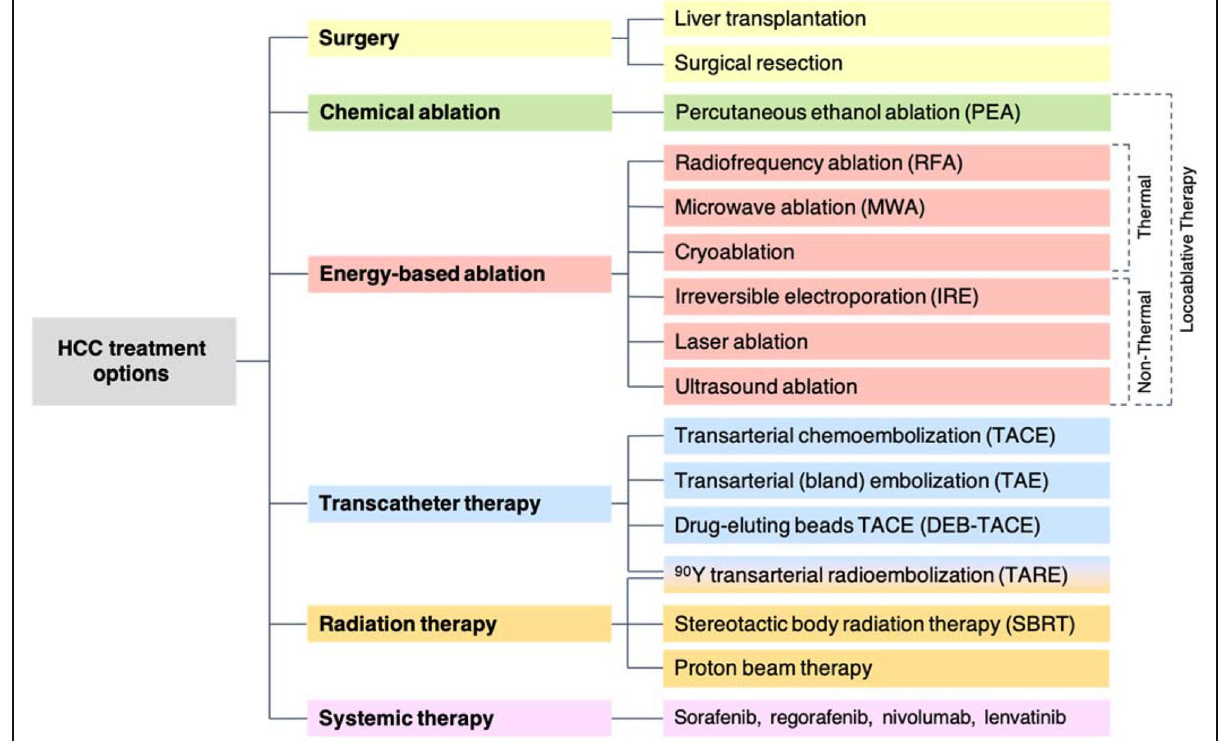
Fig. 3 Hepatocellular carcinoma (HCC) treatment options divided by modality. Locoablative therapies (PEA, RFA, MWA), transcatheter therapies (TAE, TACE, DEB-TACE, TARE) and radiation therapies (SBRT) are the most commonly used locoregional treatments for HCC treatment and